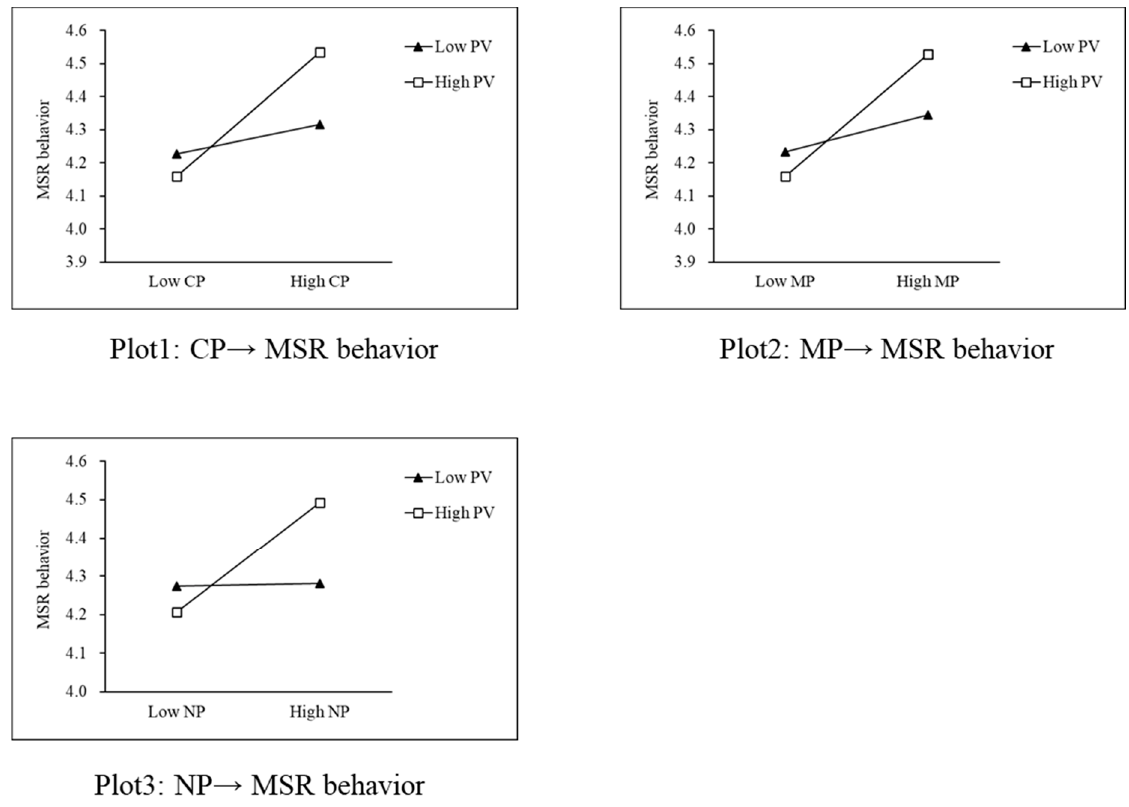
Figure 3. Moderating effect of PV on the relationship between institutional pressures and MSR behavior. Table 7. Effects of institutional pressures on MSR behavior at different levels of pure altruistic